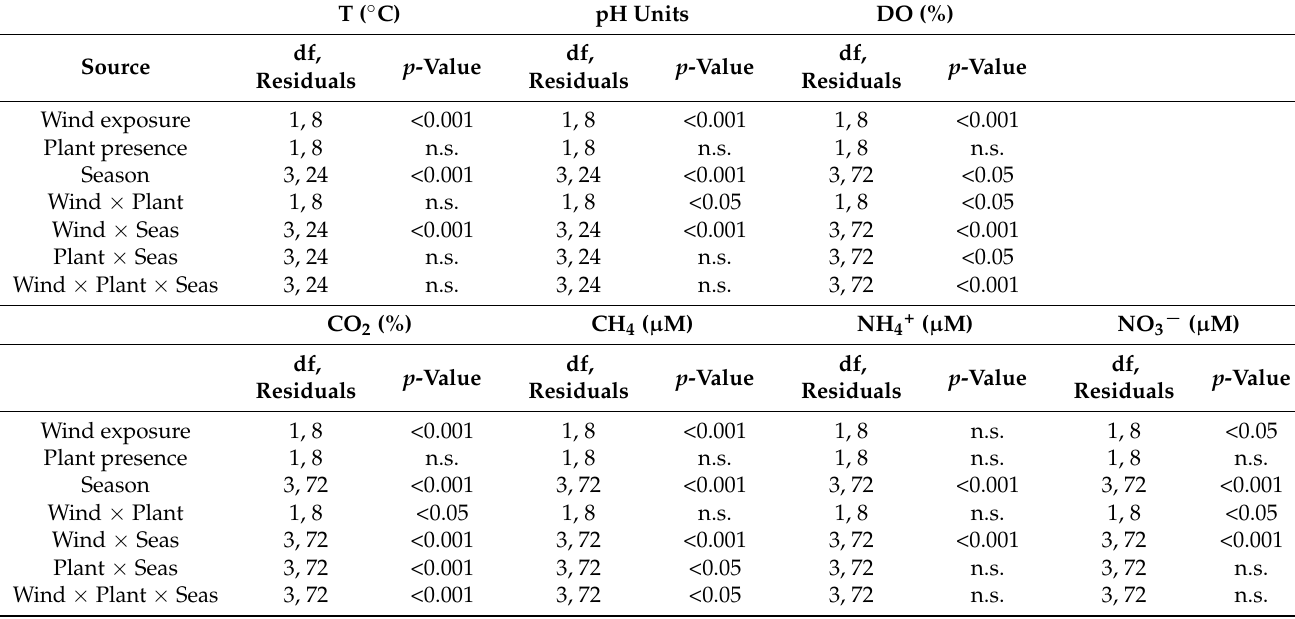
Table 2. Summarized results of the three-way ANOVA on physicochemical parameters (wind exposure, plant presence and season as fixed factors; sampling site as random factor). Results refer to seasonal campaigns carried out at 12 vegetated and plant-free sites of PAR Lake. Please refer to figures for Tukey’HSD test differences between